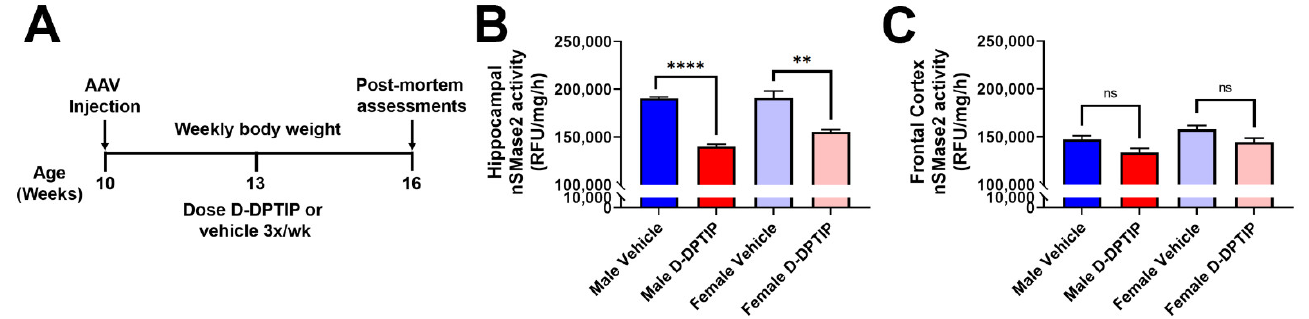
Figure 7. Orally administered D-DPTIP inhibits nSMase2 activity in the hippocampus of mutant hTau AAV injected mice. ( A ) Schematic highlighting the timing of dosing and data collection. ( B ) nSMase2 activity in the hippocampus of AAV-hTau mice 48 h following the terminal dose. Both male and female mice treated with D-DPTIP exhibited significant inhibition of nSMase2 activity. ** p < 0.01; **** p < 0.0001. ( C ) nSMase2 activity in the frontal cortex of AAV-hTau mice 48 h following the terminal dose. D-DPTIP treatment had no effect on nSMase2 activity in male and female mice. Bars represent mean ± SEM. Not significant (ns), p > 0.05.